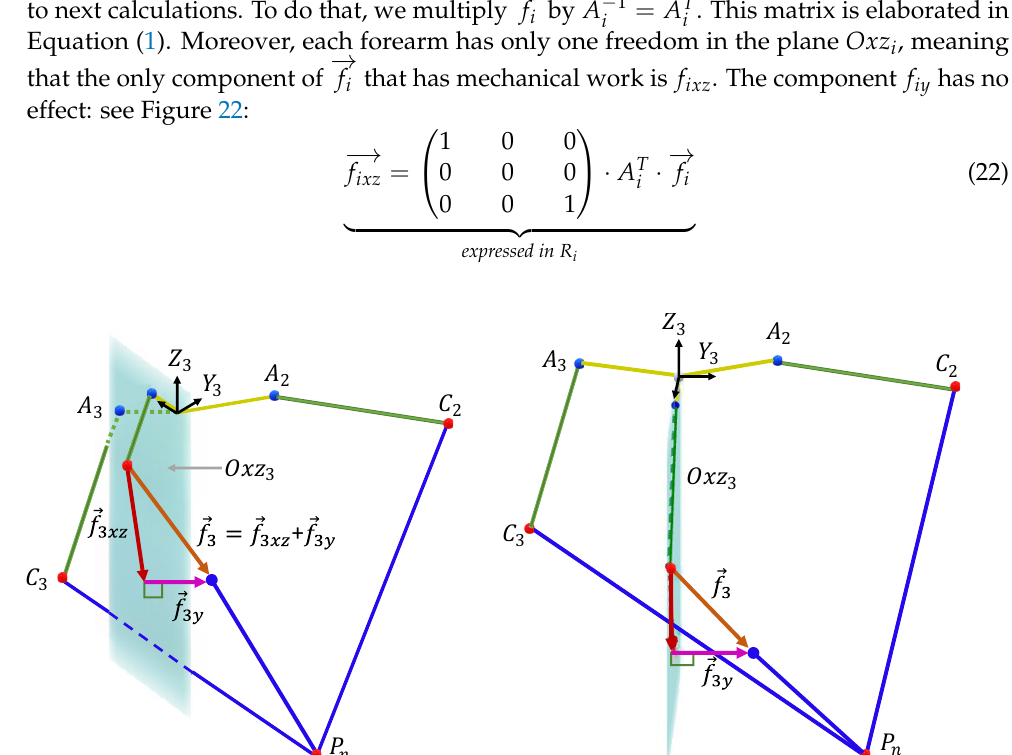
Figure 22. The projection of the force f 3 on the plane Oxz 3